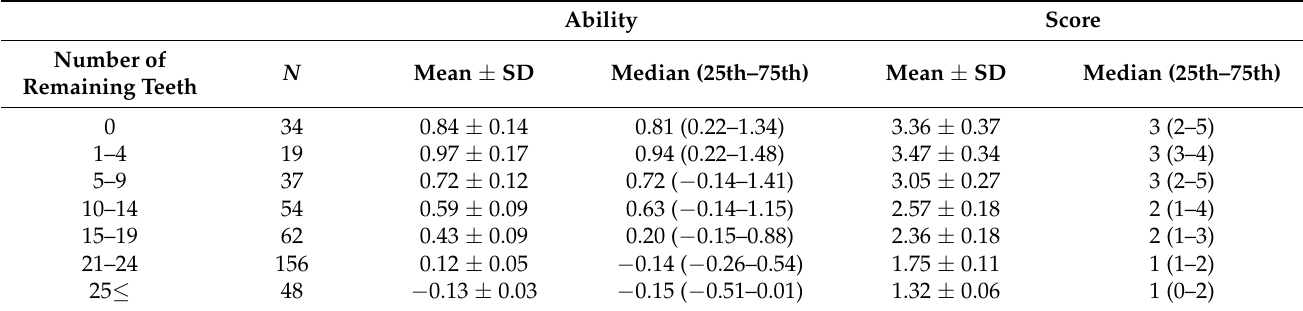
Table 1. Ability and scores by the oral frailty checklist of the groups by number of remaining teeth.